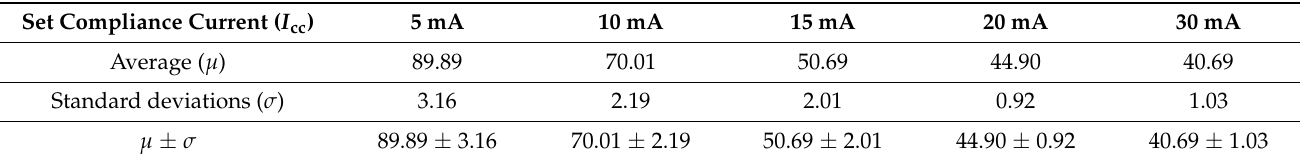
Table 2. Total low-resistance state (LRS) resistances values of average ( µ ) ± standard deviations ( σ ), according to the I cc